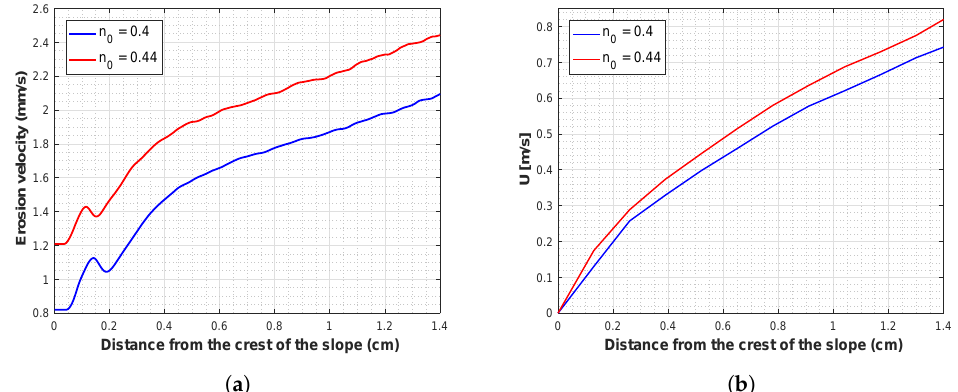
Figure 16. Comparison between numerical results for 67 ◦ breach face using different initial porosities n 0 ( a ) erosion velocity; ( b ) layer-averaged